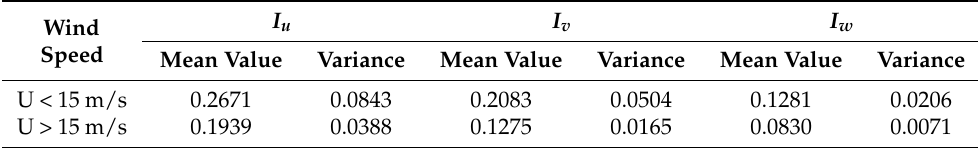
Table 3. Statistical value of the wind turbulence intensity (10 m).